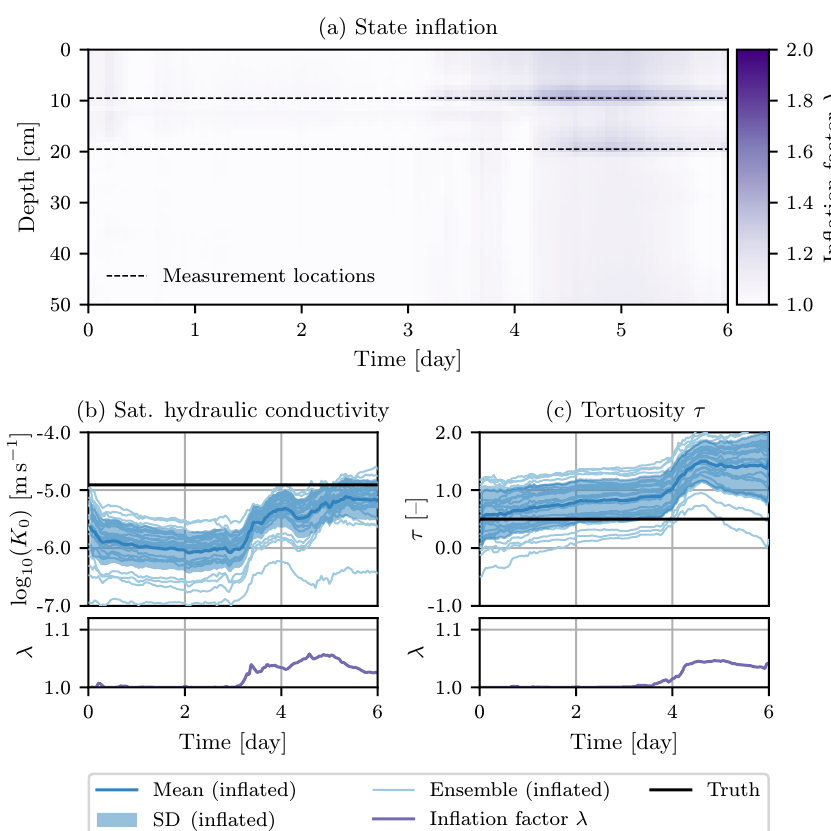
Figure 4. Development of the inflation factor for the water content state and saturated hydraulic conductivity K 0 and tortuosity τ together with their corresponding inflation factors for an estimation with a reduced inflation factor uncertainty of σ λ = 0 . 5.